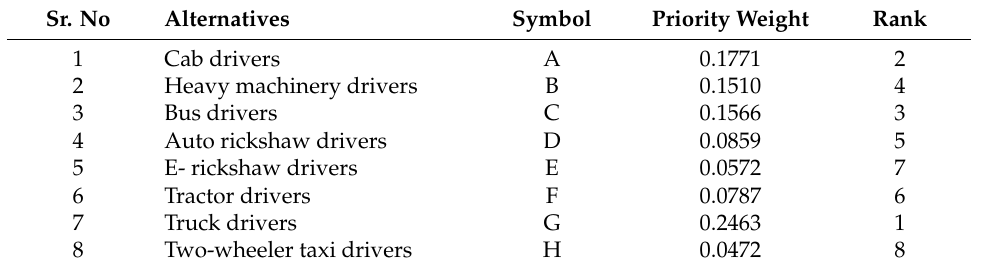
Table 11. Priority weight and ranking of alternatives.